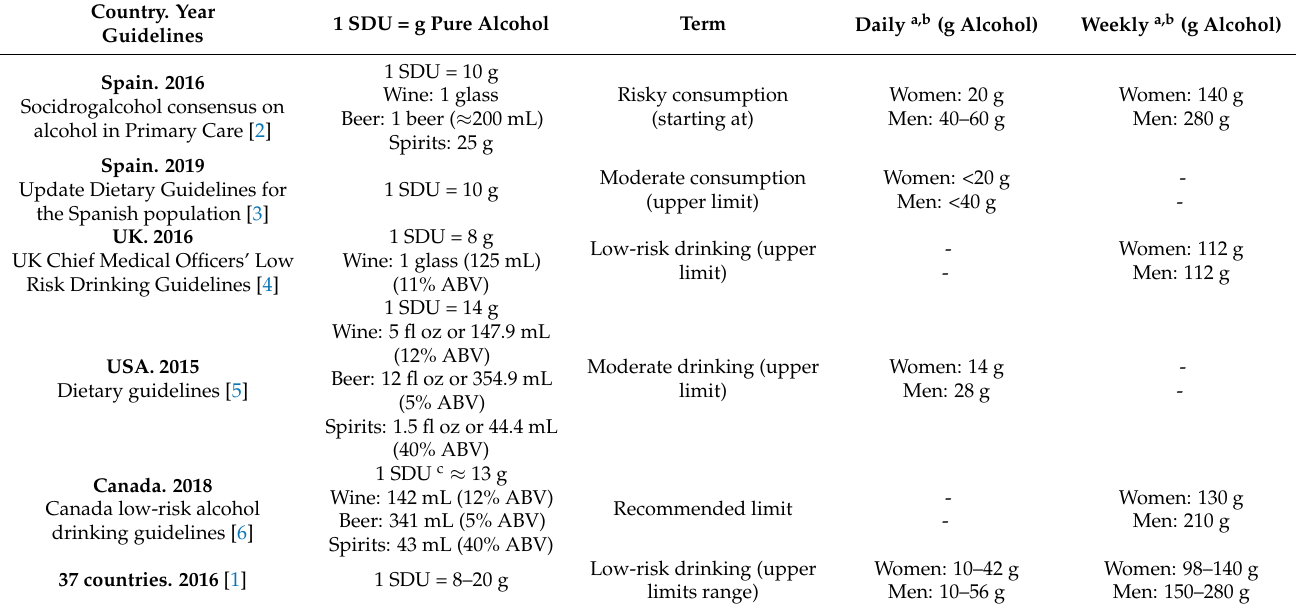
Table 1. Low-risk drinking